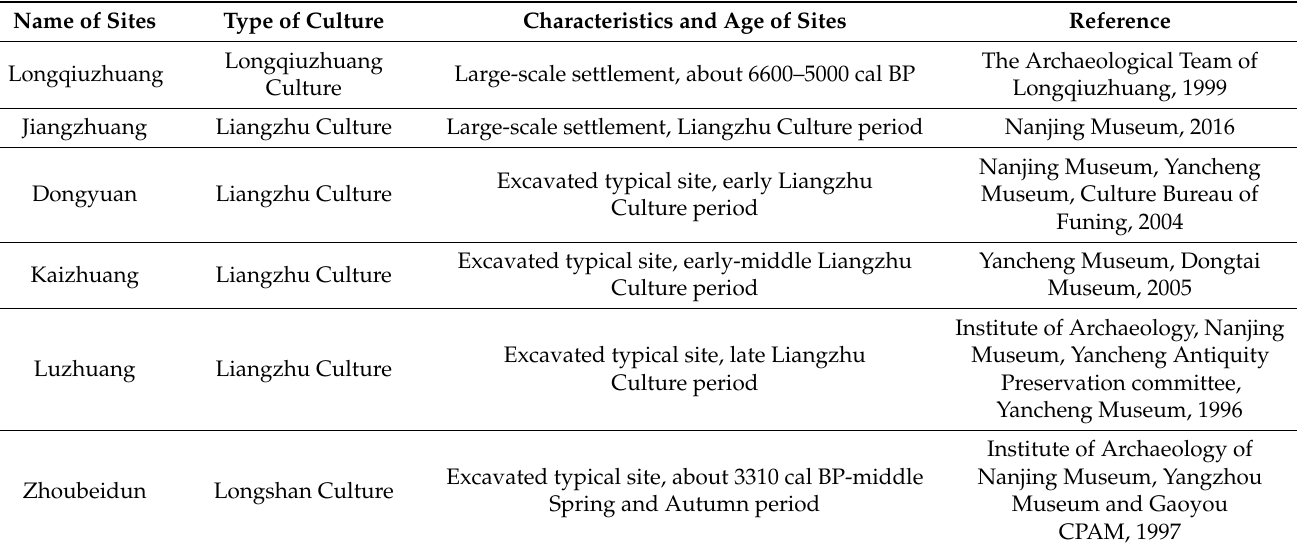
Table A1. The typical Neolithic sites in the eastern